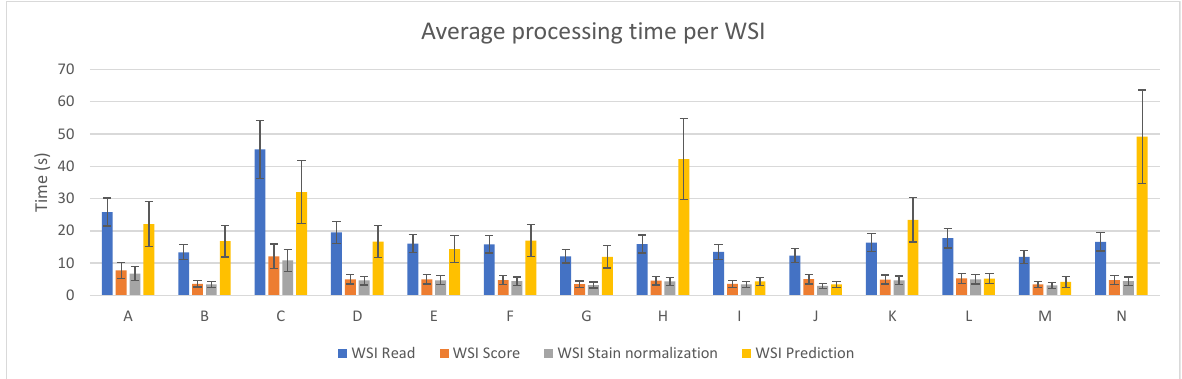
Figure 3. PROMETEO average WSI processing time (in seconds) and standard deviation per step for each of the hardware configurations detailed in Table